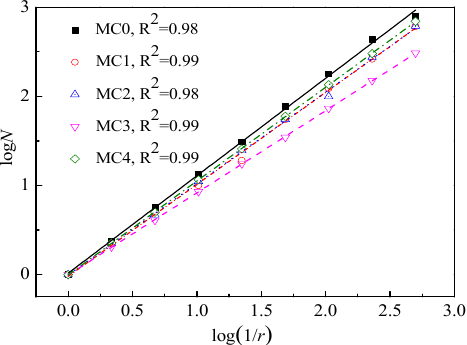
Figure 4. The log N -log(1/ r ) curve under restrained